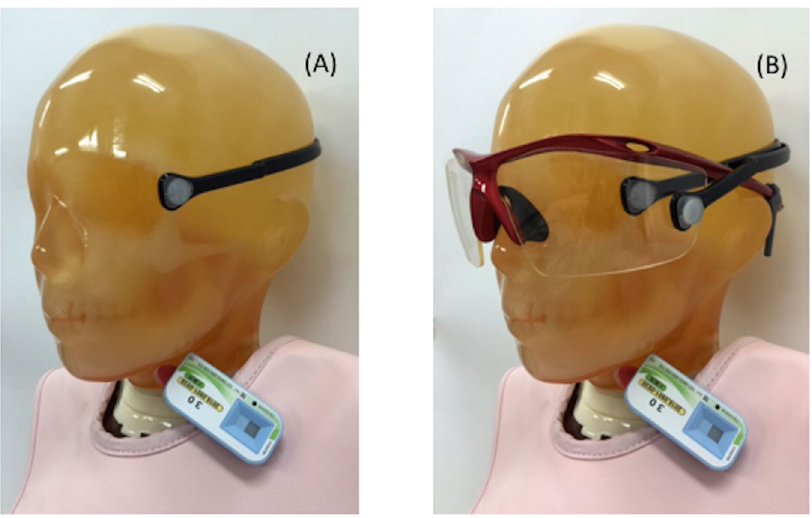
Figure 1. The positions of the dosimeters used during the procedures. The eye dosimeter (DOSIRIS) was worn just lateral to the left eye, and the personal dosimeter (badge) was worn outside the Pb apron to the left of